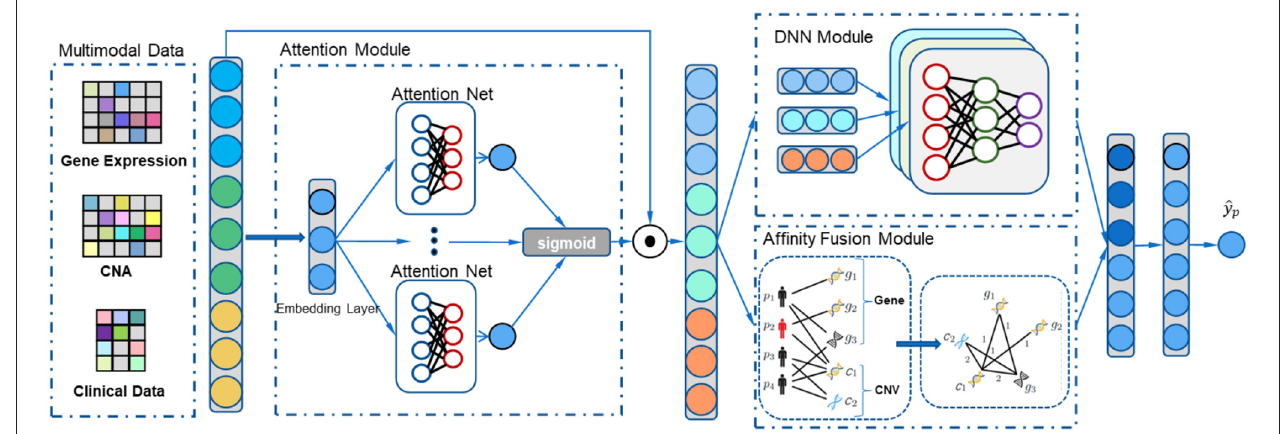
FIGURE 1 | The overall process of our multimodal affinity fusion network (MAFN) model for the breast cancer survival prediction. It mainly includes three parts: (1) attention module adaptively localize and enhance the features associated with survival; (2) affinity fusion module extracts multimodal data fusion features; (3) DNN module extracts each modal specific